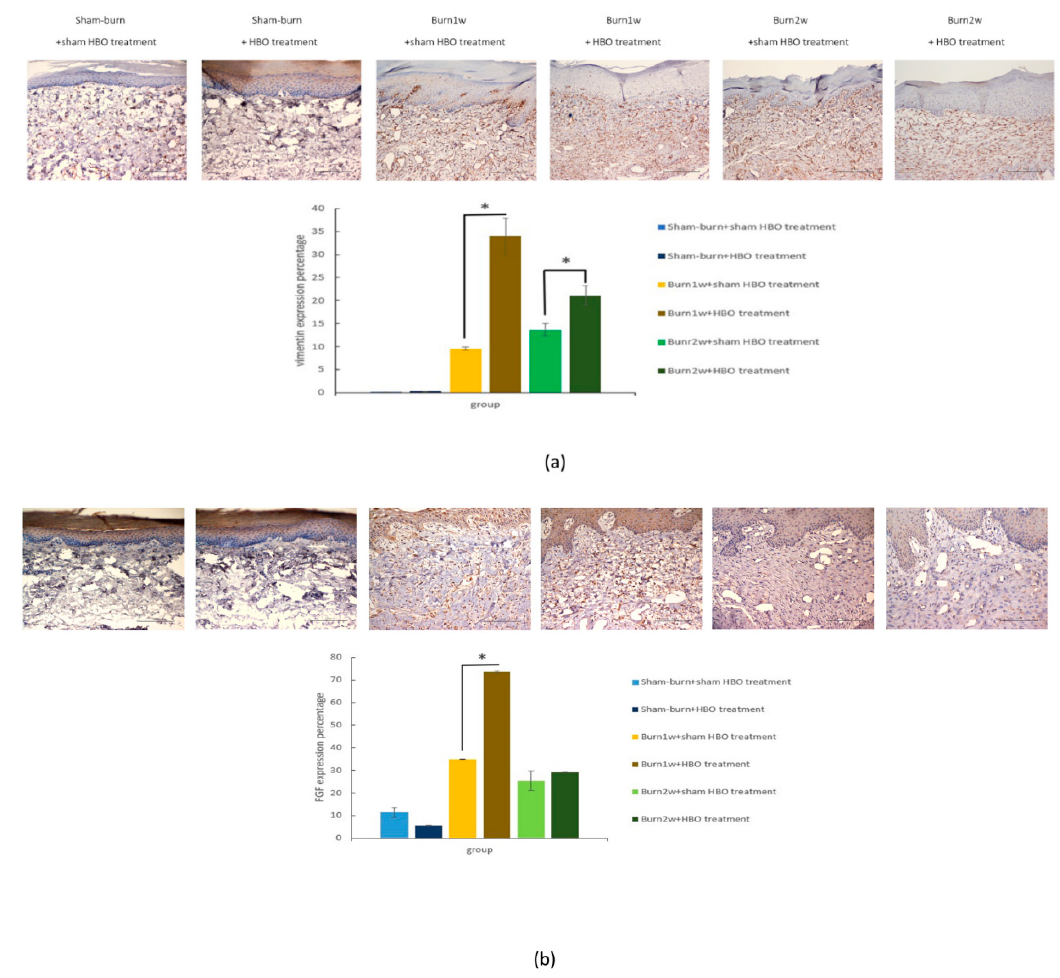
Figure 7. ( a , b ) HBO treatment increased vimentin and fibroblast growth factor expression. Immunohistochemistry (IHC) analyses of vimentin and fibroblast growth factor (FGF) in hind paw skin histologic specimens at one and two weeks after burn injury. Vimentin expression increased significantly in the burn with HBO treatment group compared with the burn with sham HBO treatment group. FGF expression increased in the burn with one-week HBO treatment group compared with the burn with one-week sham HBO treatment group. * p < 0.05, original magnification: ×20.